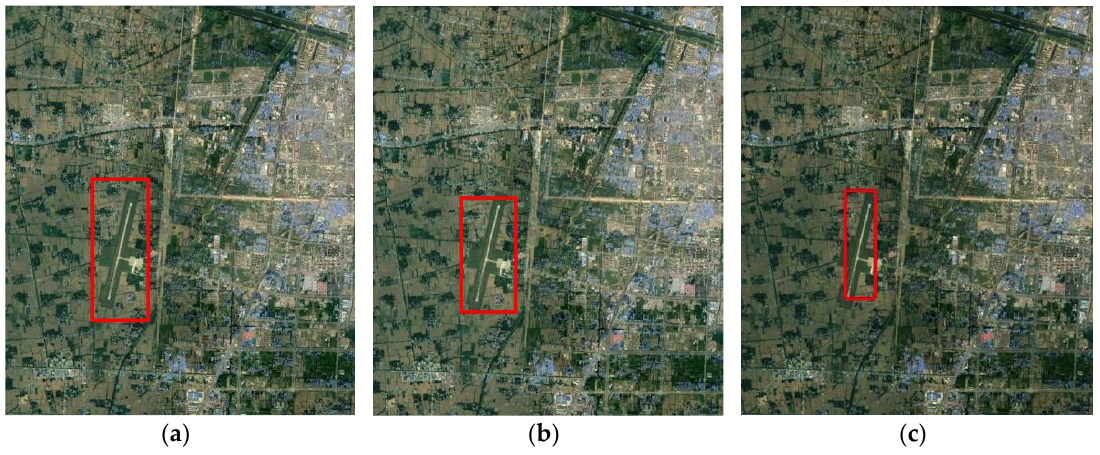
Figure 9. True detection results of different methods. ( a ) Faster R-CNN; ( b ) proposed method; ( c ) LSD + AlexNet. [Image courtesy of Google Earth].